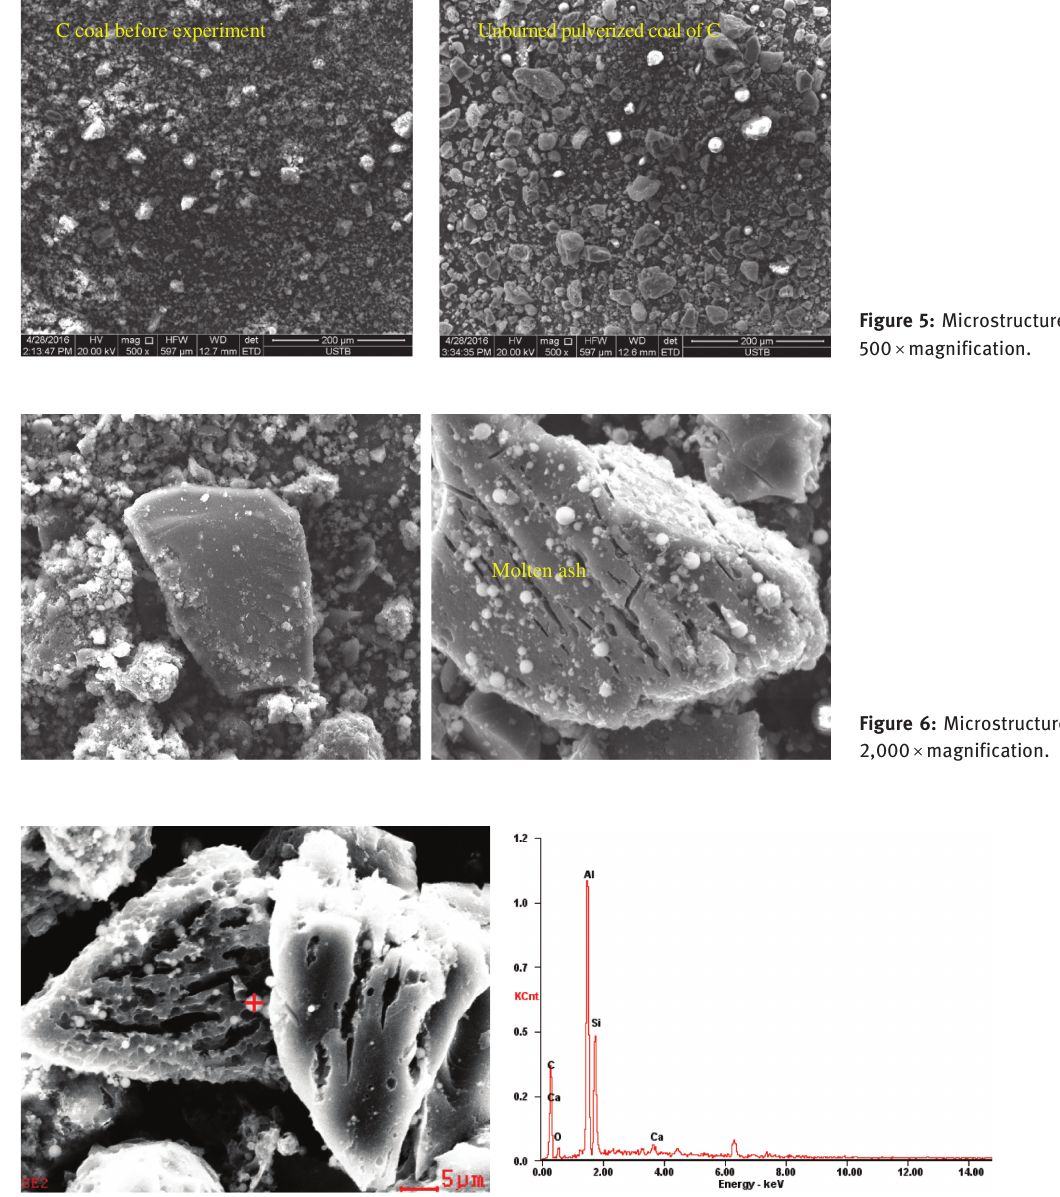
Figure 7: Energy spectrum analysis of spherical particle in unburned pulverized